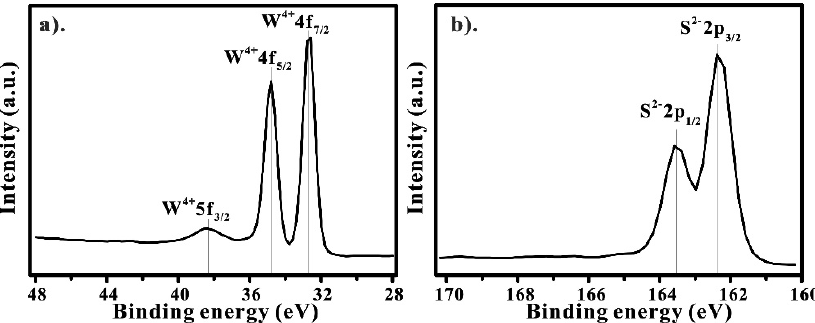
Figure 2. High-resolution XPS of WS 2 films: ( a ) W 4f and W 5f signals; ( b ) S 2p.